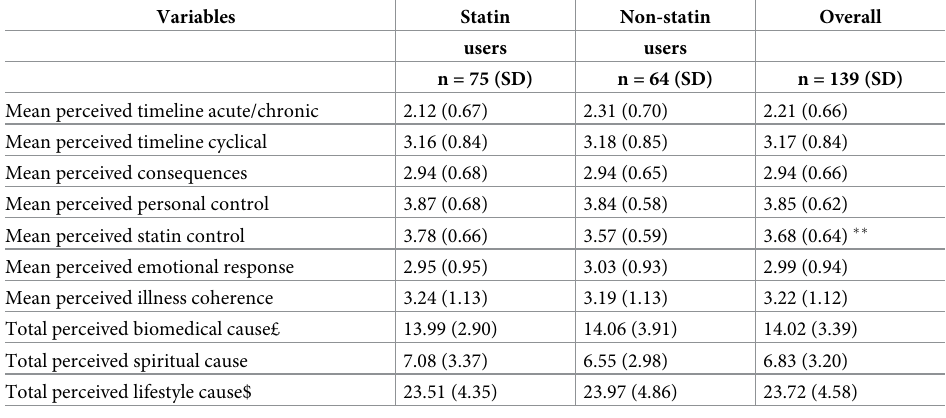
Table 4. Perceptions of high